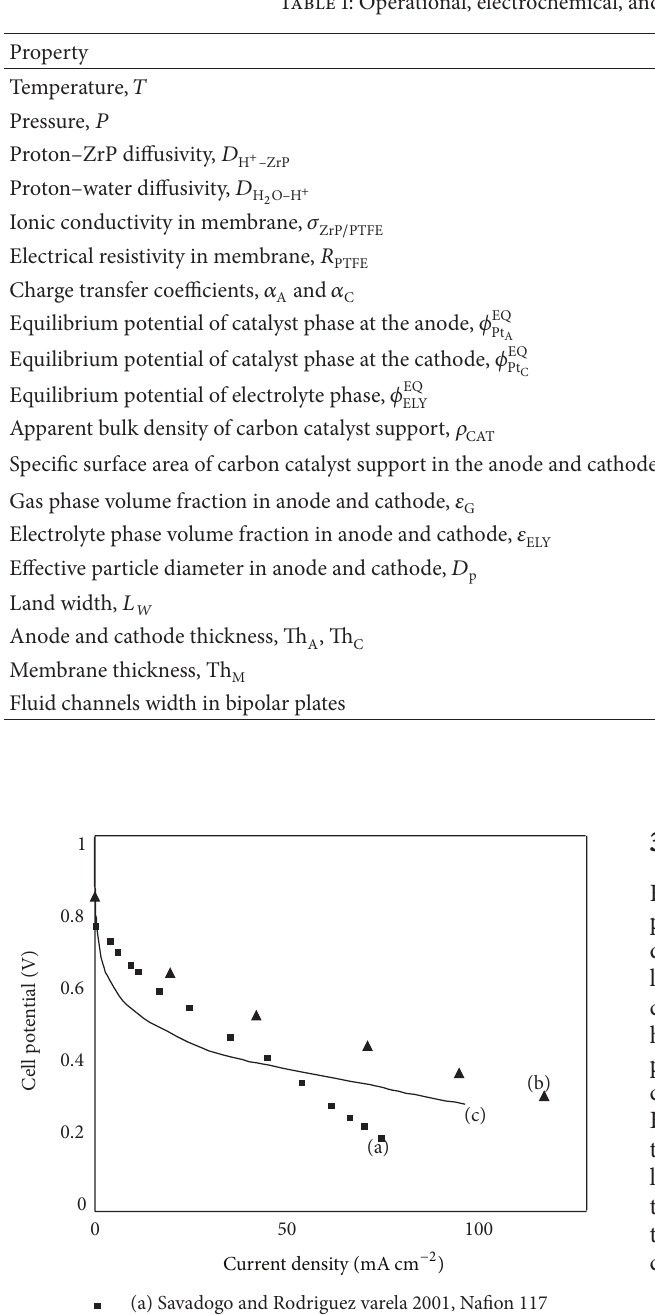
Table 1: Operational, electrochemical, and design parameters for simulations.